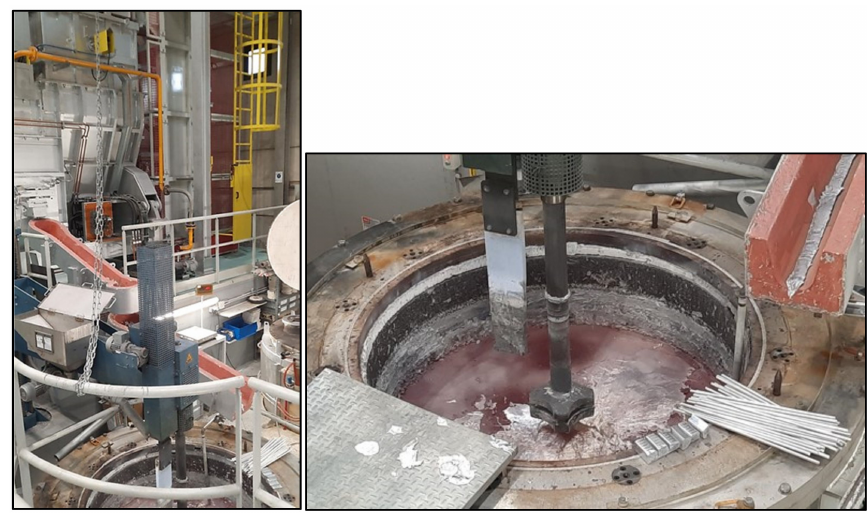
Figure 2. Gas tower furnace used for melting process (image on the left ) and ladle used for degassing, adjustment of composition and addition of AlSr10 and Al5Ti1B master alloys (image on the right